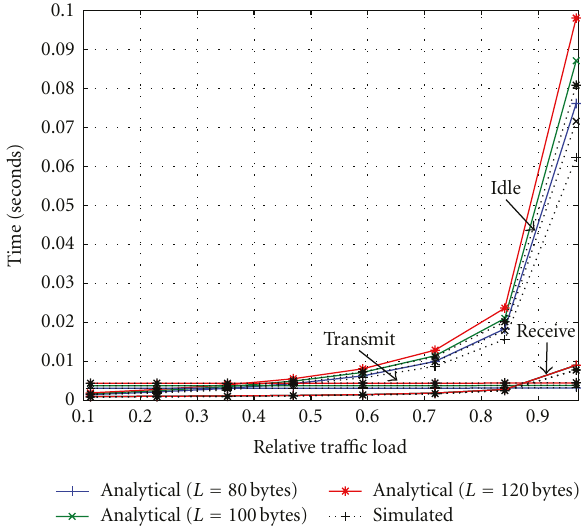
Figure 9: DQ-MAC time spent in transmit, receive and idle mode: Analytical versus Simulated